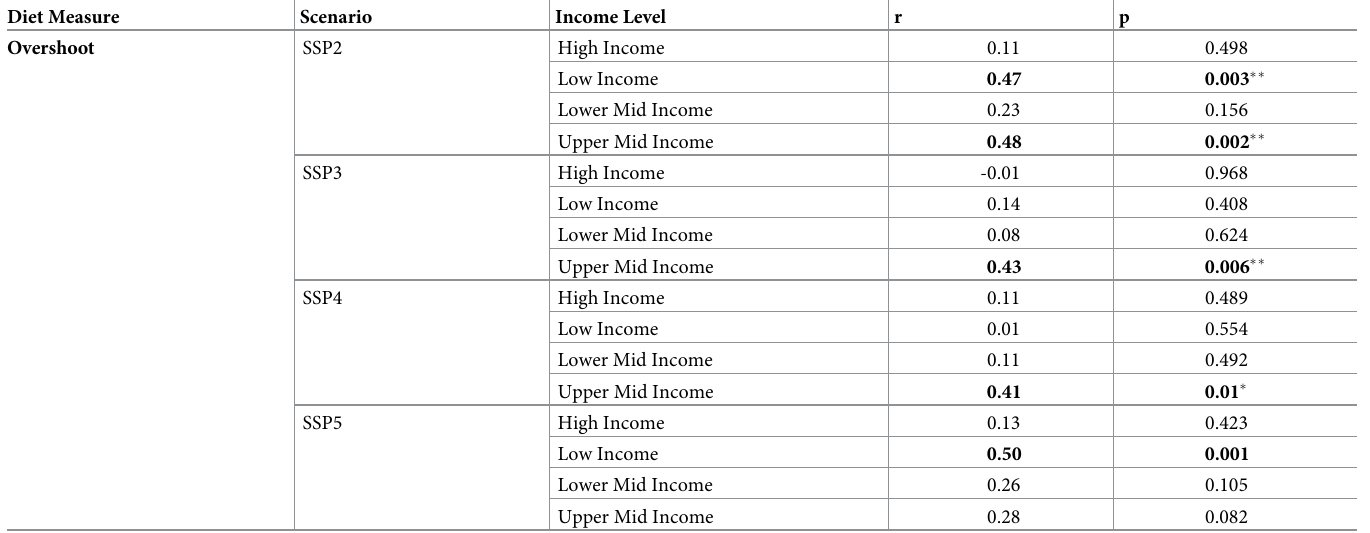
Table 4. Cross-country correlations tracking the change in country-level overshoot (arithmetic mean of food group category-level overshoot) between 2010 and 2050 and the change in imports per capita between the years 2010 and 2050. Aggregation by income is via global income quartiles, and are roughly analogous to